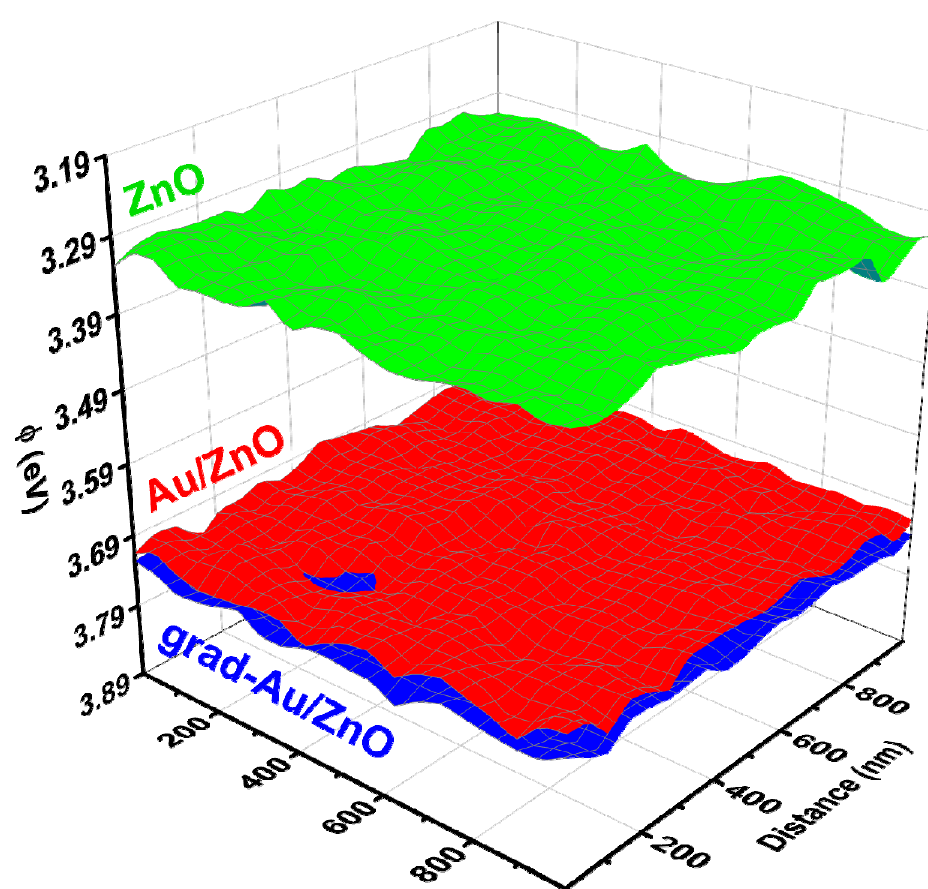
Figure 4. Work function with respect to variations in CPD over photoanode samples. Table 2. Physical properties: flat band potentials and CBM and VBM positions estimated at pH 7.